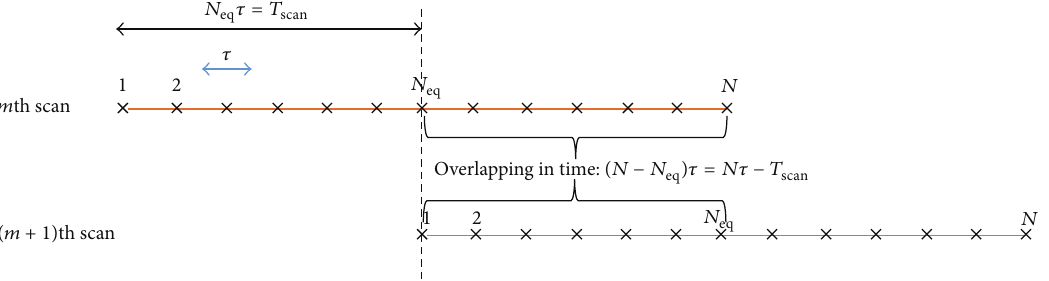
Figure 4: Time intervals covered by the array over successive